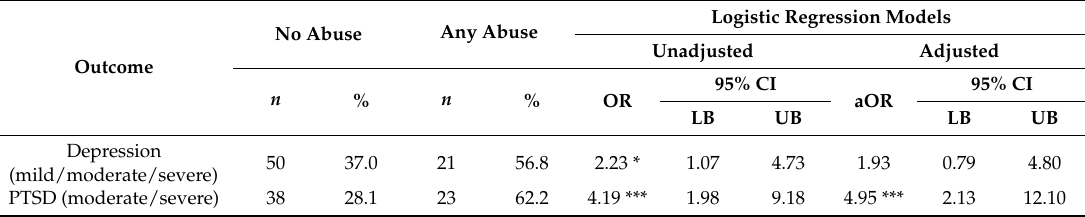
Table 4. Descriptive statistics and Odds Ratios (ORs) from Logistic Regression models predicting Depression and Posttraumatic stress disorder (PTSD)